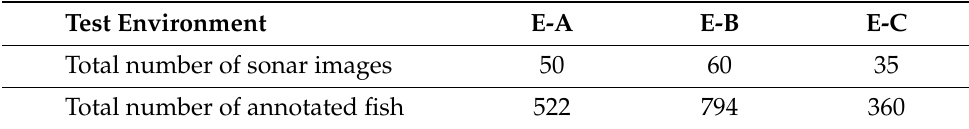
Figure 6. An example of the annotation image: ( a )sonar image; ( b ) annotation image. Table 1. The specifications of the